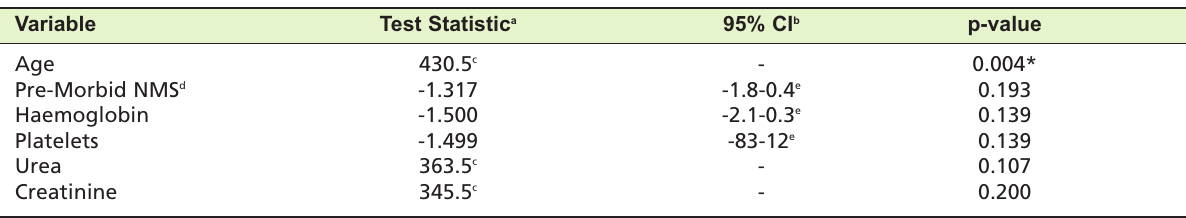
(a) Univariate analyses of potential continuous predictive variables for one year mortality. (b) Univariate analyses of Table VI: potential categorical predictive variables for one year